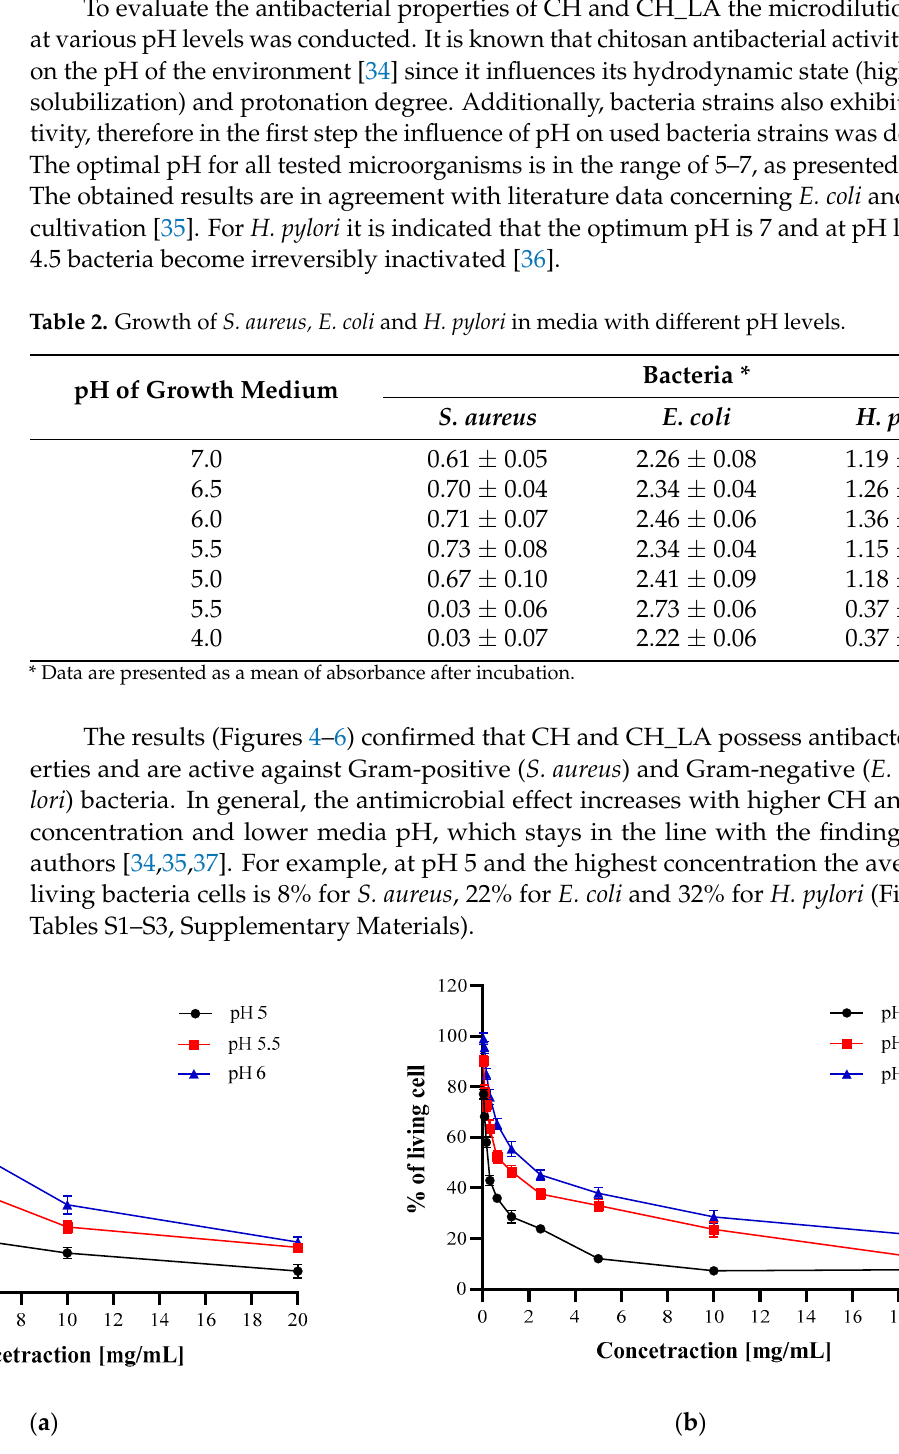
( b ) Figure 5. Antibacterial properties of CH ( a ) or CH_LA ( b ) against E. coli at different pH levels. In the case of E. coli , at the highest concentration at all media pH levels, as well as at the whole concentration range at pH 4 and 4.5, CH_LA exhibits stronger antibacterial ac- tivity (Figure 5, Tables S2 and S3). At pH 5 and above, the activity of CH and CH_LA is comparable. The shape of the curves is similar (practically at all concentrations, for pH 5 to pH 6) which implies that both materials interact with bacteria in a similar manner, de- spite the molecular structure differences, which is opposite to the above-presented Gram- positive S. aureus results.